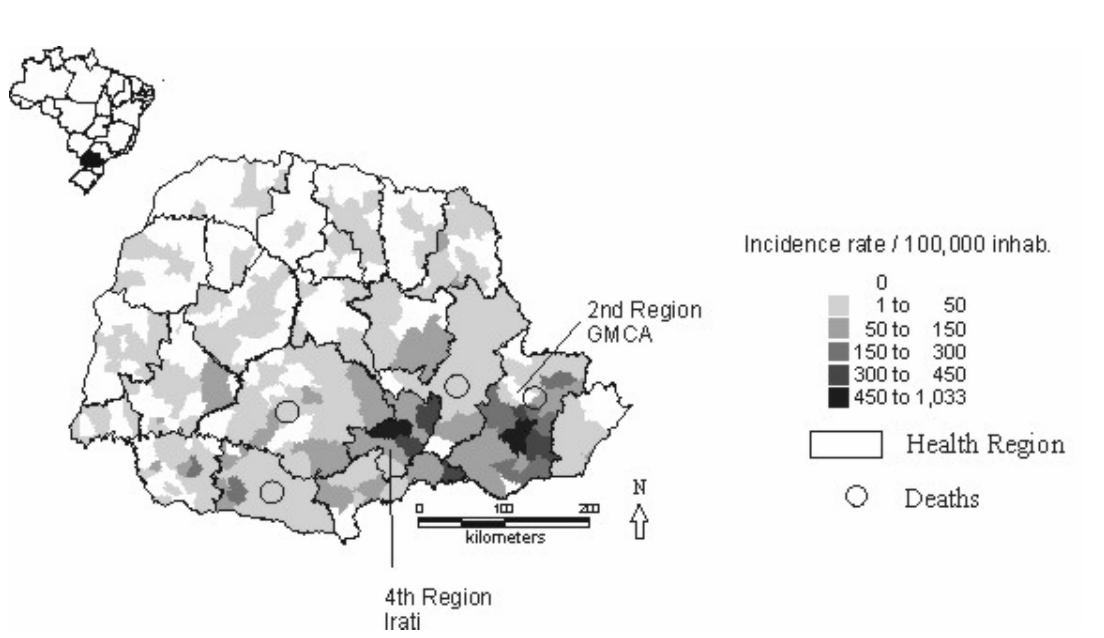
Figure 1: Spatial distribution of the incidence rate of Loxosceles bites and deaths in the state of Paraná, Brazil,